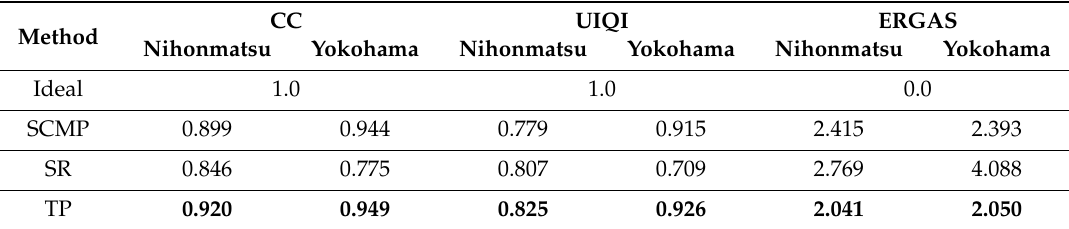
Table 5. Numerical evaluation of image intensities obtained by SCMP, SR, and the tradeo ff process. The best values are given in bold.